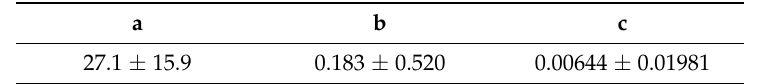
Figure 2. The location of the farm used to observe milk yields, eight observatories and the Japanese low frequency transmitting station (JJY) for very low frequency/low frequency (VLF/LF) propagation data. Red lines represent the propagation path from JJY to the eight observatories. NSB = Nakashibetsu; AKT = Akita; IMZ = Imizu; KTU = Katsuura; KMK = Kamakura; TYH = Toyohashi ANA = Anan; STU = Suttu. Table 1. Estimated parameters in Equation (1) for individual lactation curves (Mean ± Standard